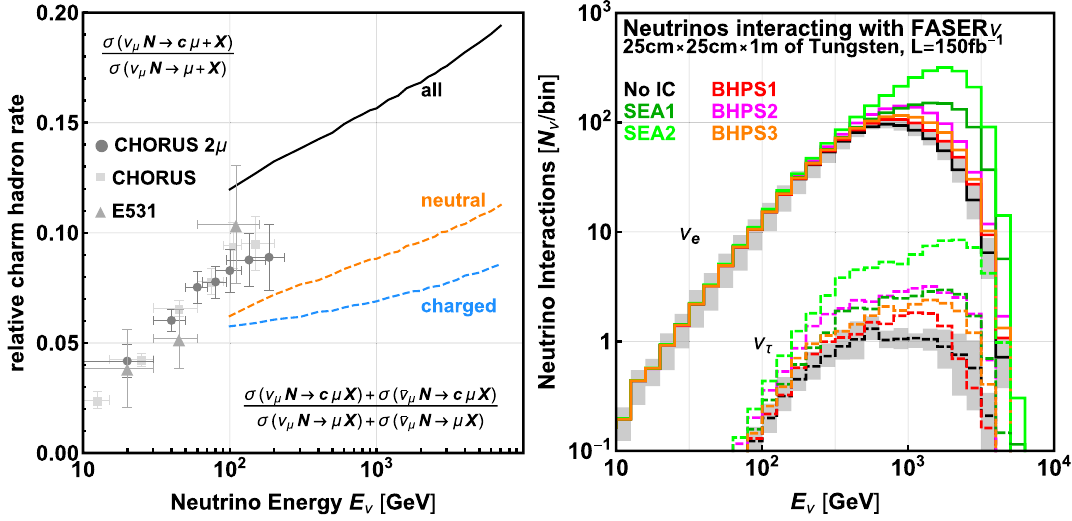
Fig. 19 Left : Relative charm hadron production rate in neutrino inter- actions. The solid black curve shows the expected fraction of charm- associated neutrino interactions in the FASER ν detector as a function of neutrino energy, obtained with Pythia 8 . The dashed blue and orangecurvefurtherseparatethefractionintochargedandneutralcharm hadrons, respectively. The gray error bars show the results of previous